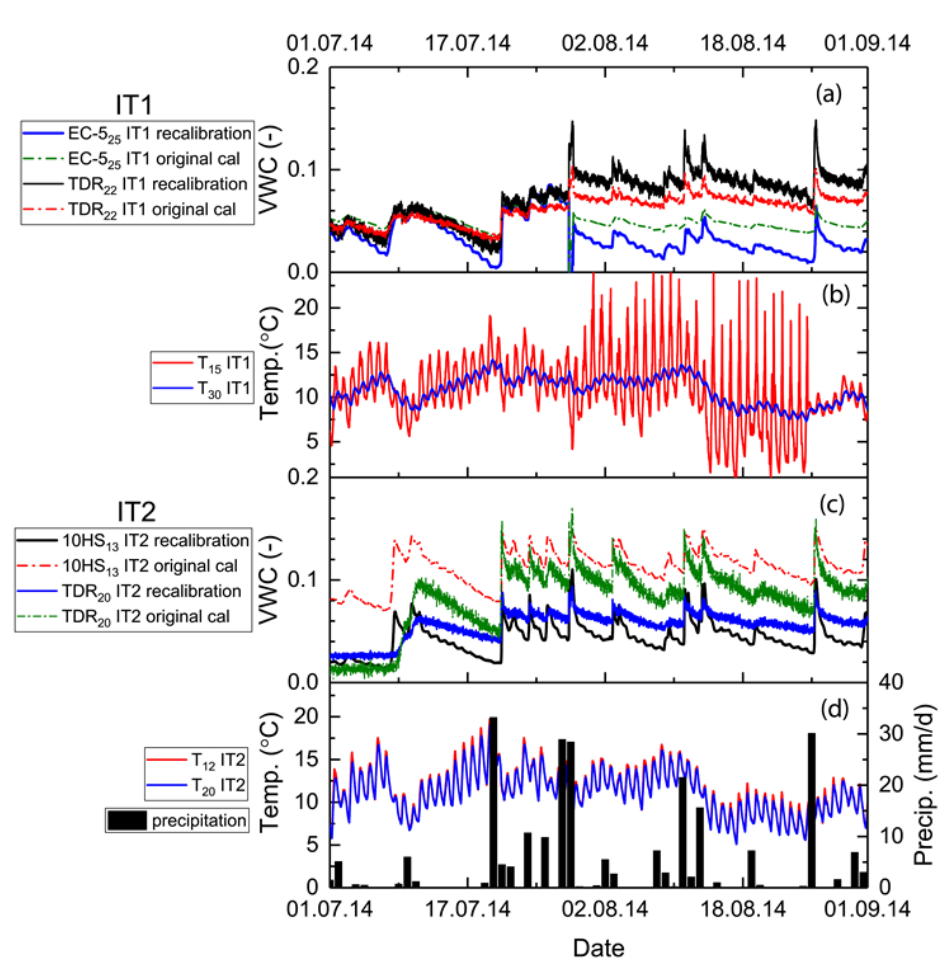
Figure 13. Data Period 1: 1 July 2014–31 August 2014. Site-specific calibration: comparison between data based on original calibration and the recalibration for the summer period.